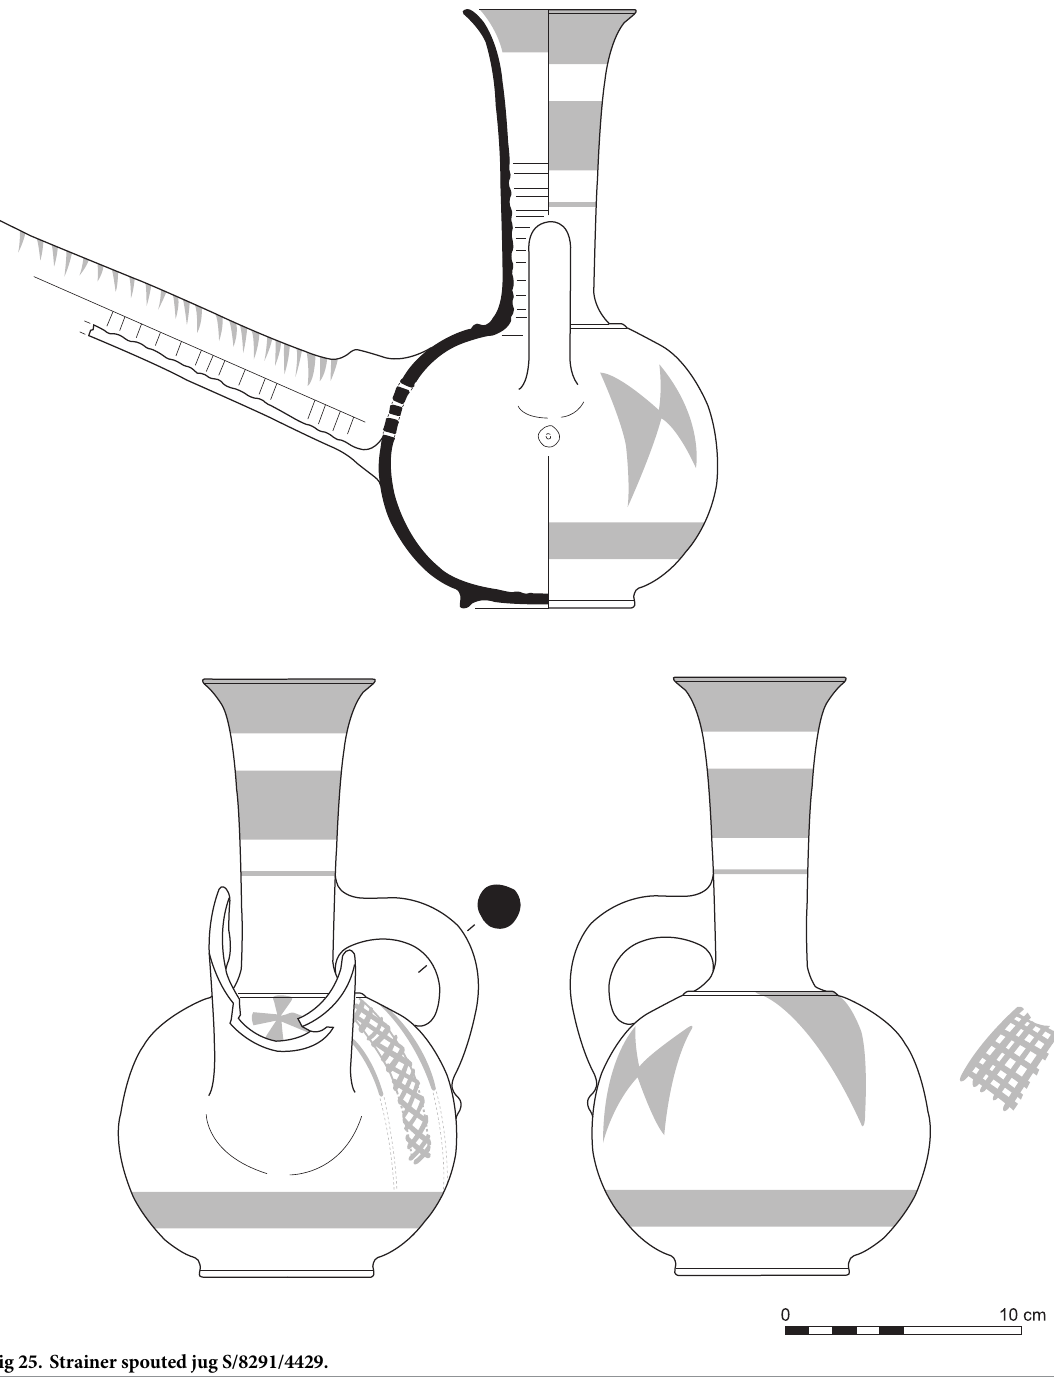
Fig 25. Strainer spouted jug